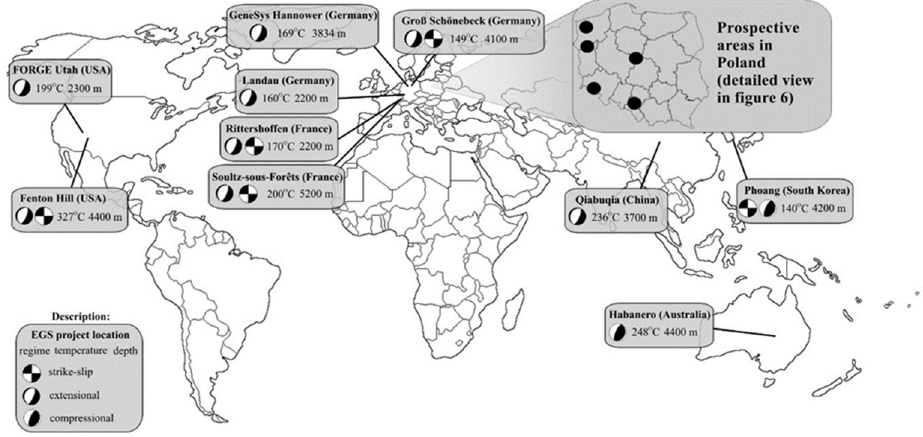
Figure 5. EGS projects reviewed in this paper. Beach balls represent the tectonic